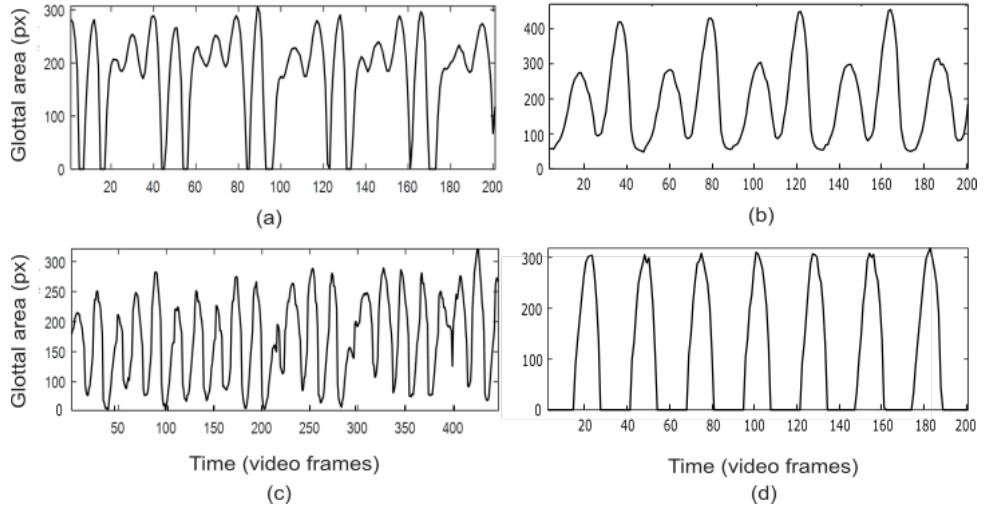
Figure 2. Glottal area waveforms (GAWs) extracted by segmentation of the high-speed videos (HSVs): ( a – c ) vocal fry and ( d ) euphonic voice. ( a ) illustrates an example of a CAMP = 4 type GAW, having four pulses in a modulator cycle; ( b ) illustrates an example of CAMP = 2 type, where each modulator cycle contains two pulses; and ( c ) belongs to an example of the Acyclically Amplitude Modulated Pulse train (AAMP) type, which is acyclically modulated. The euphonic GAW has smaller amplitude modulations than the vocal fry GAWs.